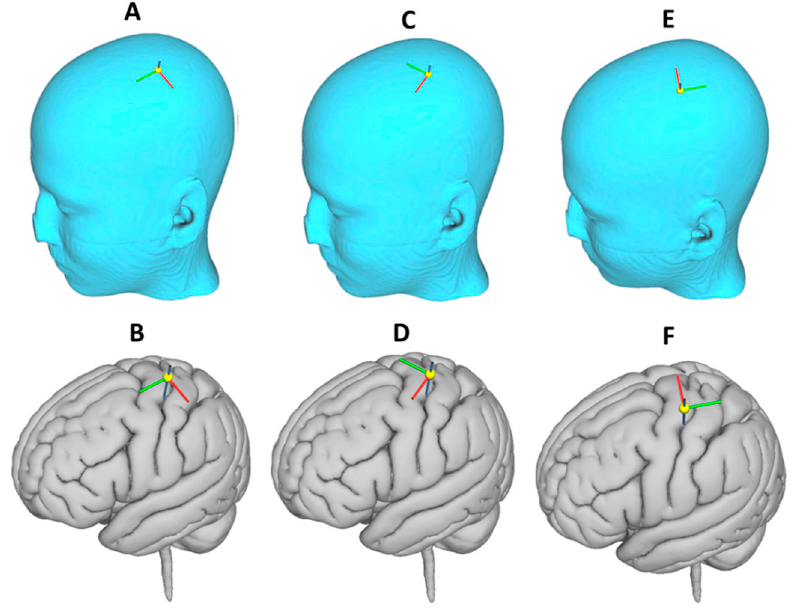
Figure 3. Transcranial magnetic stimulation (TMS) coil orientations examined. The green limb indicates the direction of current in the coil. ( A , B ) Current flow towards Nz. ( C , D ) Current flow towards FCz. ( E , F ) Current flow towards Oz. Nz, FCz, and Oz are standard positions in the 10-10 electrode system for EEG recording. The ( A , C , E ) panels show the coil orientation on the skull and the ( B , D , F ) panels show the coil projection on the cortical surface.